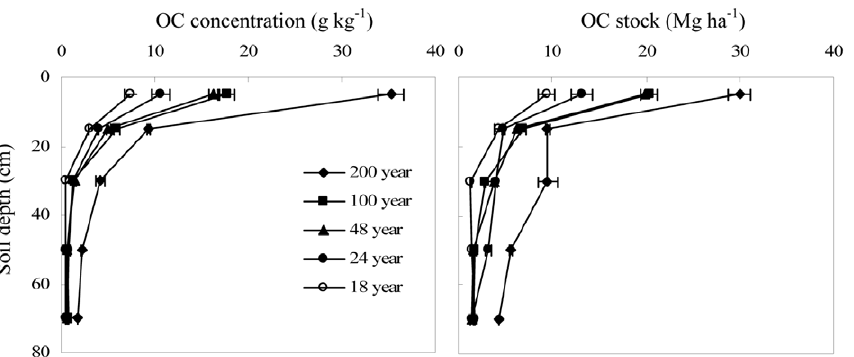
Figure 4. Vertical distribution of forest-derived OC (C 3 -C) concentrations and OC stocks in afforested farmland (the error bars are standard deviation of the means).